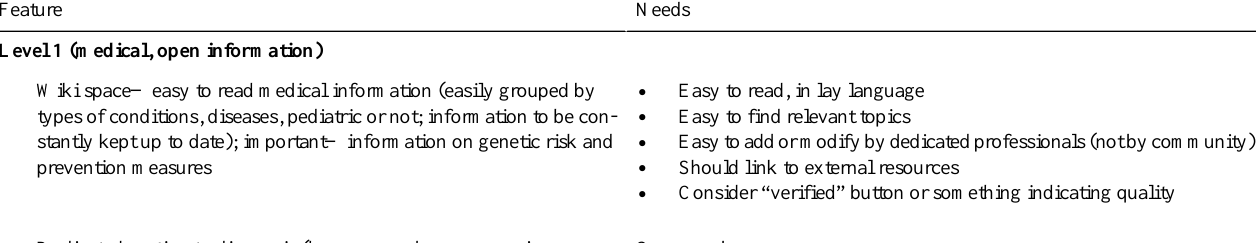
Table 2. Summary of the most needed features or feature types identified following Workshop 1.